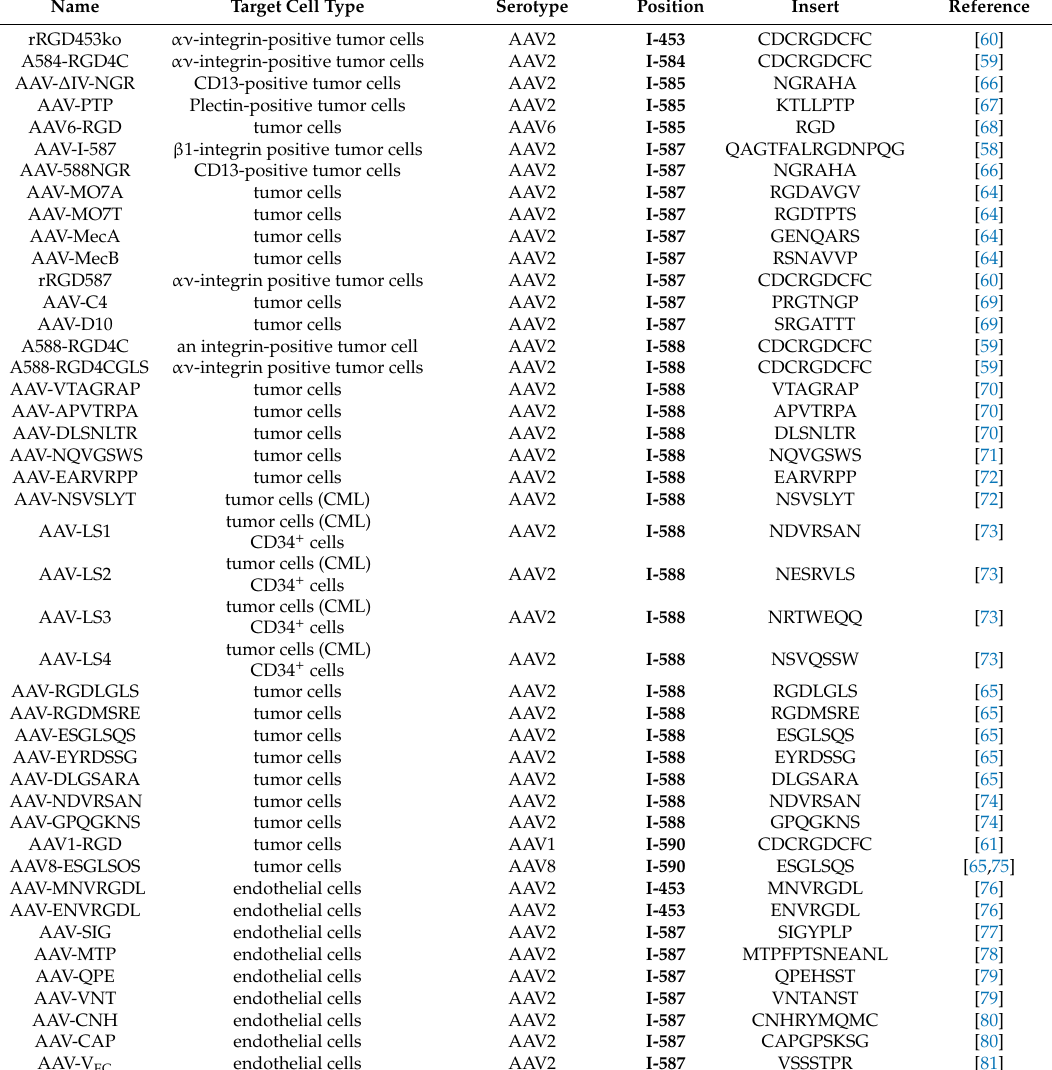
Table 2. Peptide insertion into the common VP3 region of AAV capsid proteins for tumor